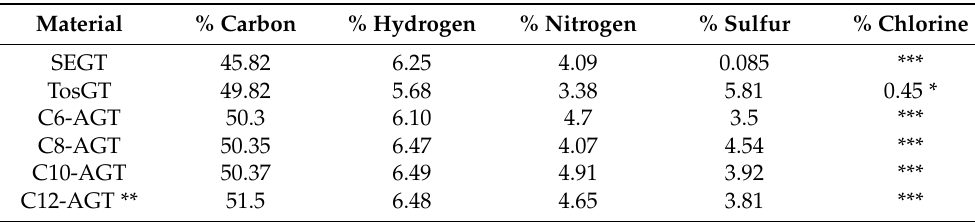
Table 2. Elemental analyses.